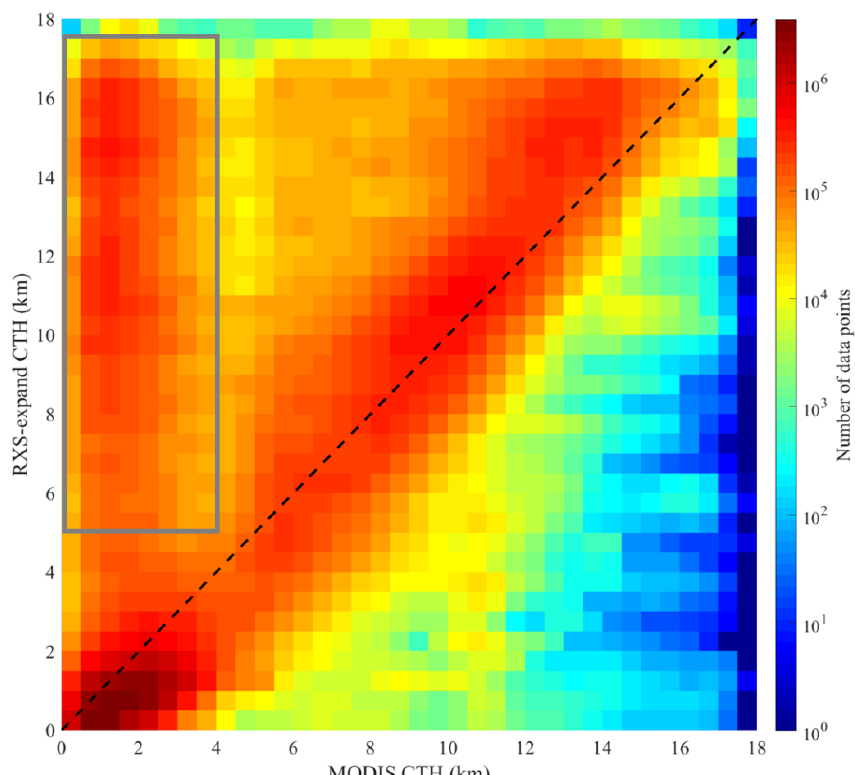
Figure 8. Comparison of CTH inferred from the retrieved cross section (RXS)-expand results up to 400 km on both sides of the ground track and collocated MODIS retrievals. The gray box indicates a mismatch caused by attributing a donor with high thin cloud layer on top of the low cloud layers detected by MODIS.